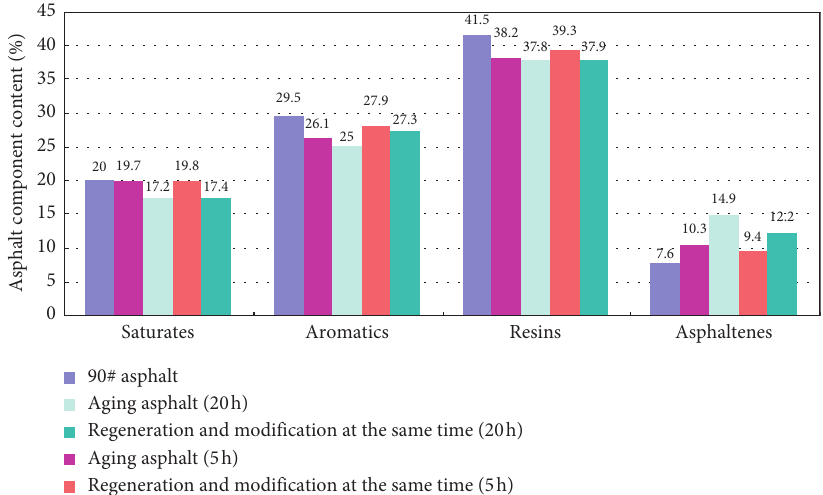
Figure 10: Asphalt component relationships in different aging